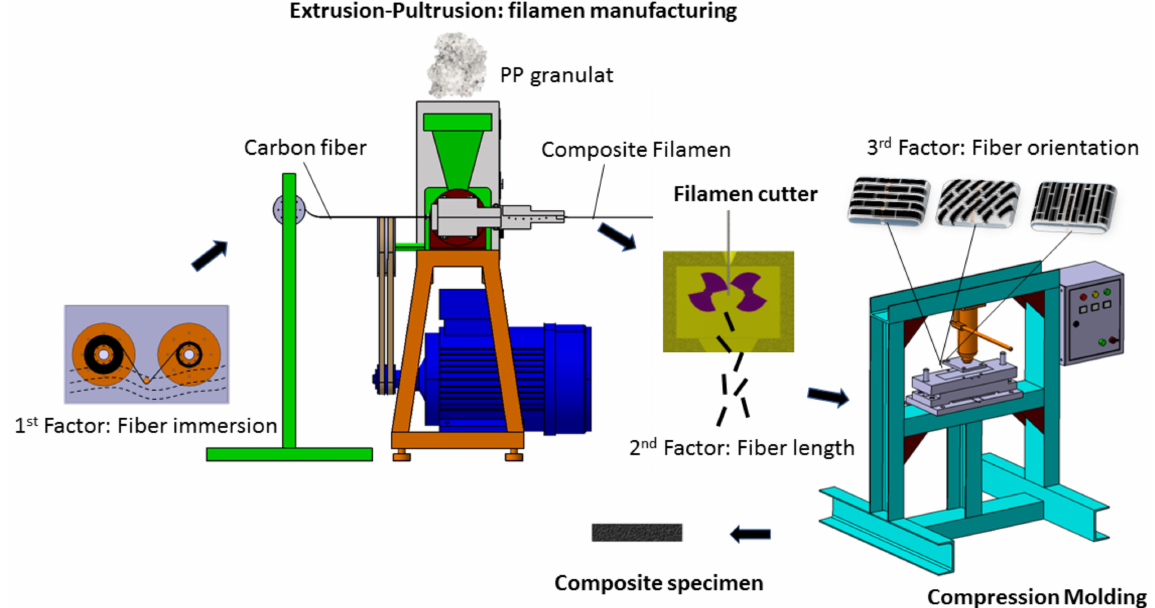
Figure 2. Preparation of composite specimen involving three factors: fiber immersion, fiber length, and fiber